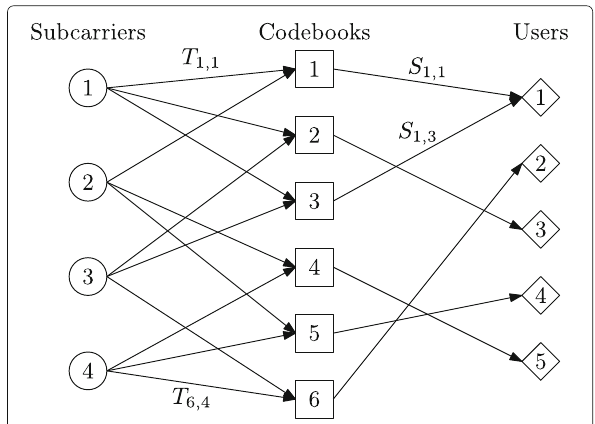
Fig. 2 An example of a mapping scheme in SCMA